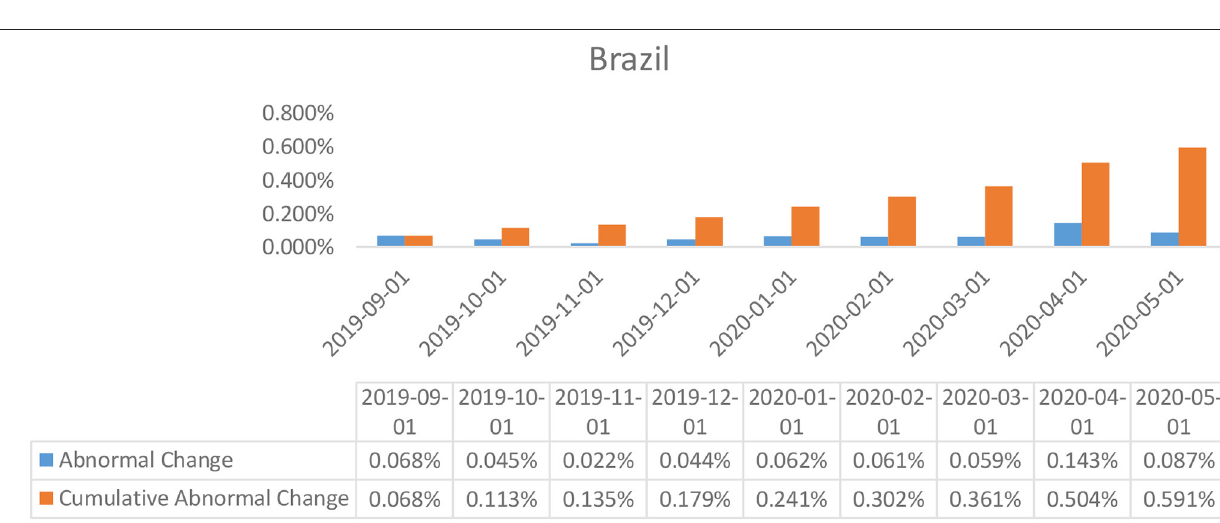
FIGURE 5 | Abnormal changes in policy interest rates over the event window: